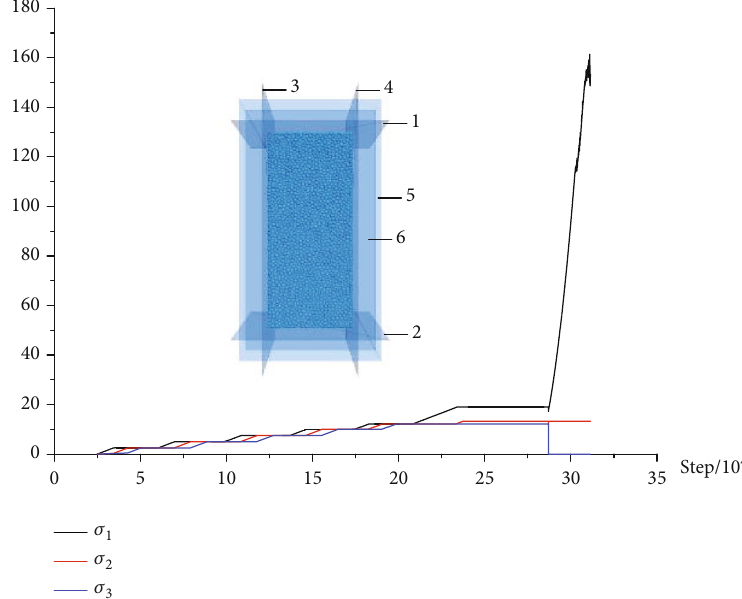
Figure 8: Rock burst numerical model and loading path.